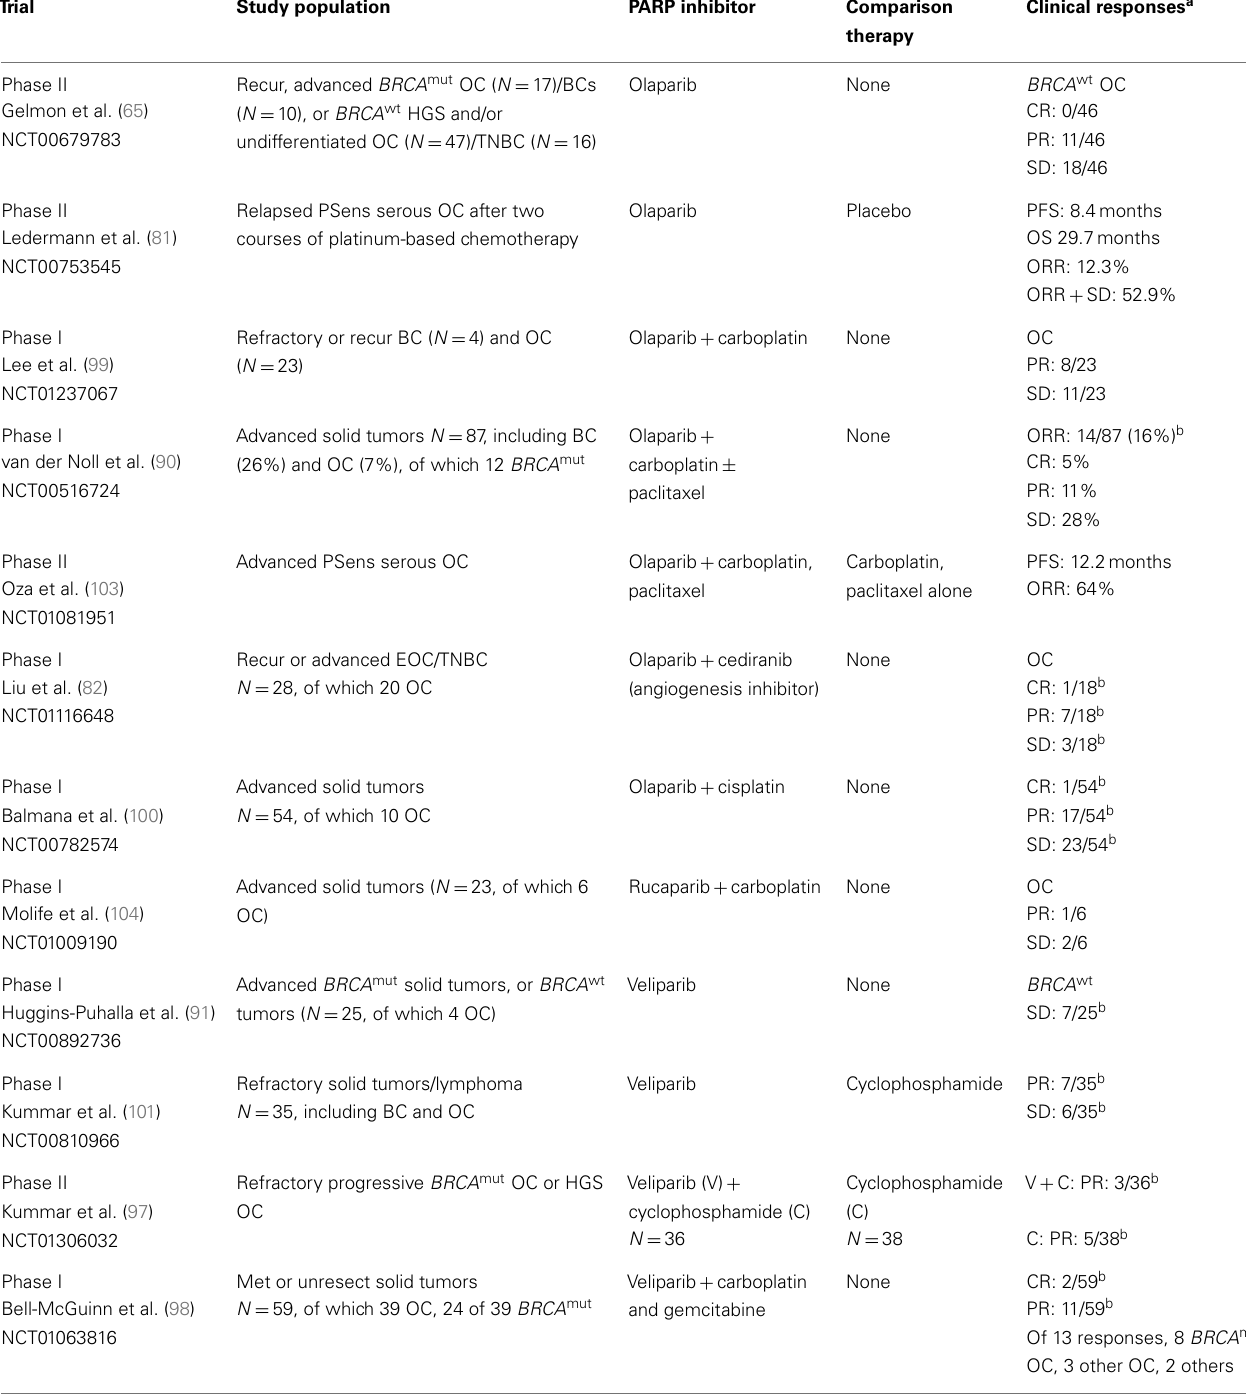
Table 4 | Selected PARP inhibitor trials in sporadic ovarian cancers